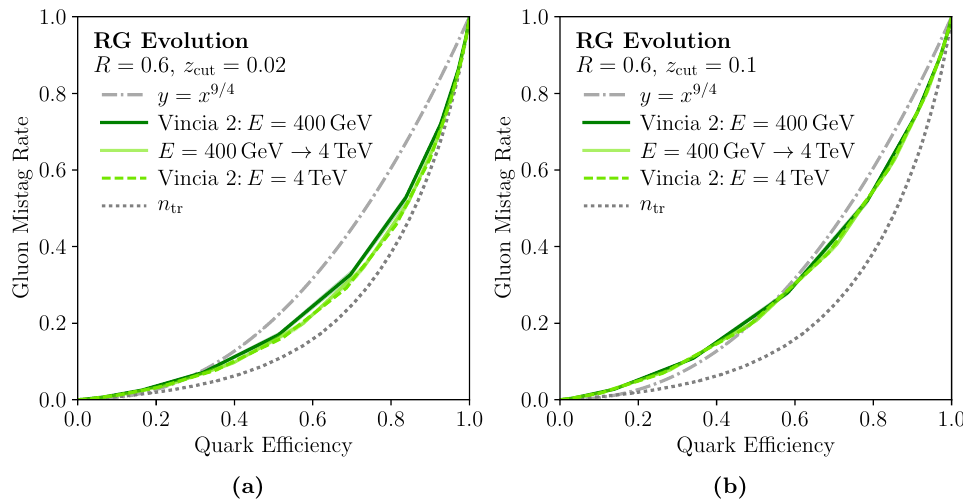
Figure 17. RG evolution of ROC curve (quark singlet vs. gluon) for the collinear-unsafe soft drop multiplicity with (a) z cut = 0 : 02 and (b) z cut = 0 : 1. In both cases, there is very little evolution in the discrimination power with energy